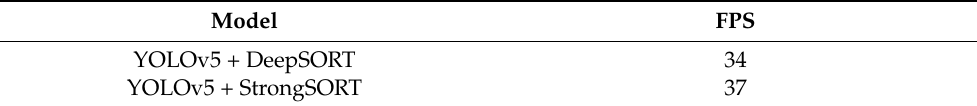
Table 3. Comparison of FPS.